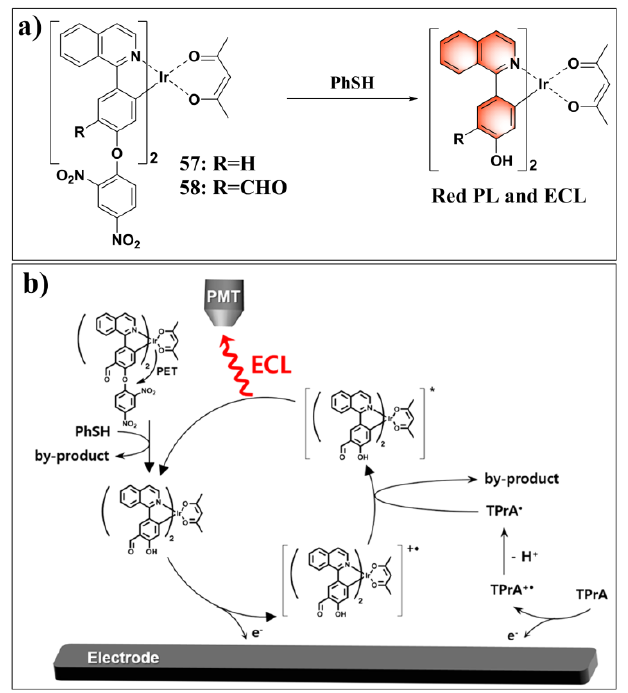
Figure 24. ( a ) Structures and reactions of probes 57 – 58 with PhSH. ( b ) Electrochemiluminescence (ECL) sensing mechanism of probe 58 for PhSH. Reproduced with permission from Reference [137]; copyright American Chemical Society.